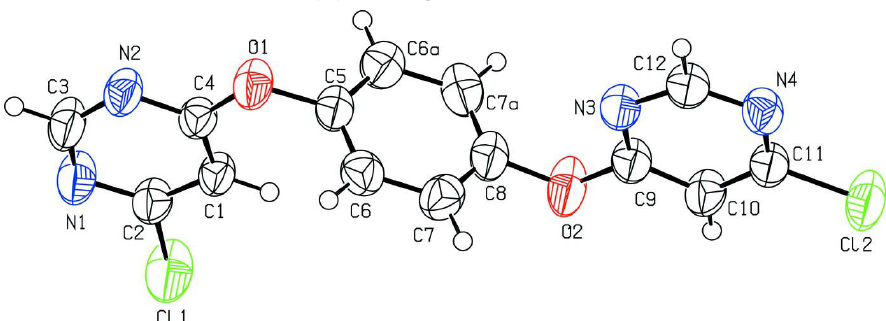
The molecular structure of (I), showing the atom-numbering scheme. Displacement ellipsoids are drawn at the 20% probability level [Symmetry codes: (a) x ,- y , z